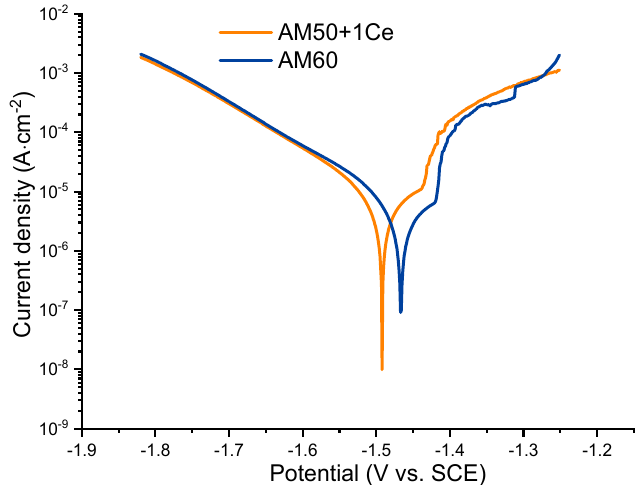
Figure 11. Potentiodynamic polarization behavior of HPDC AM50+1Ce and AM60 magnesium alloys in 3.5wt% NaCl solution. in 3.5 wt% NaCl